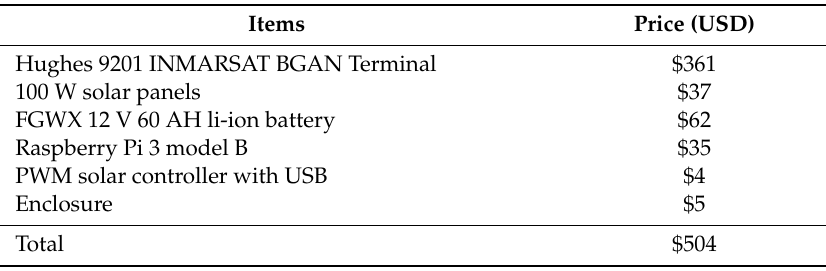
Table 3. The capital cost of the access point.